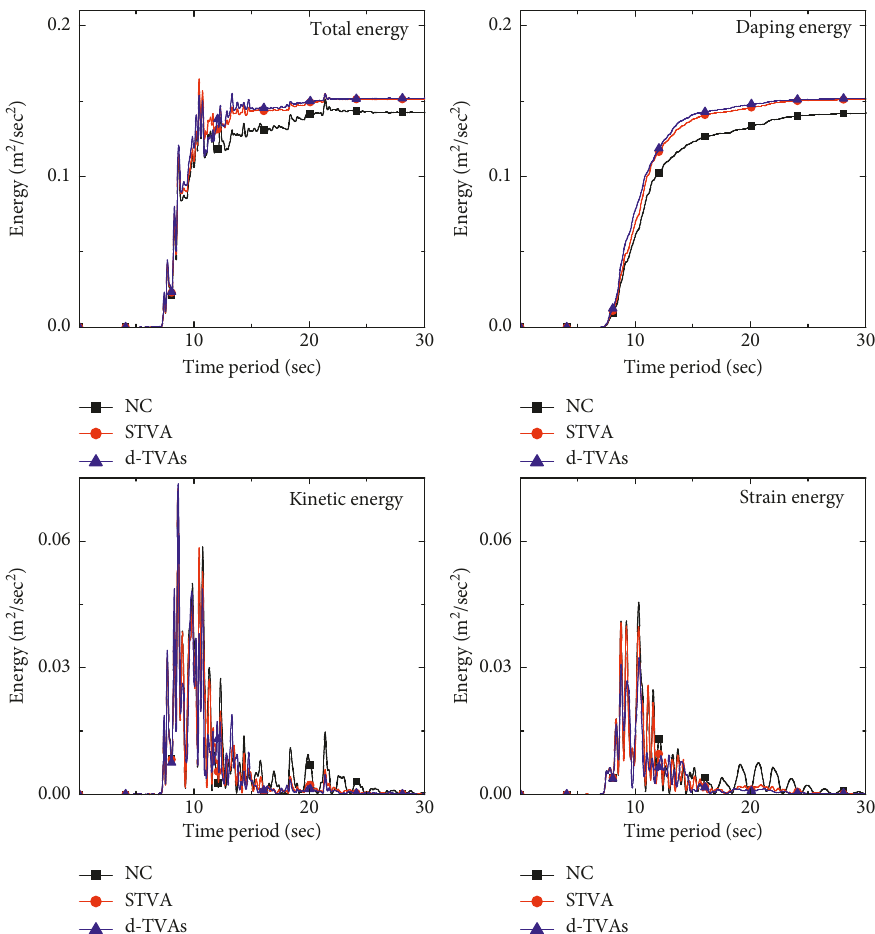
Figure 6: Different energies for the NC, STVA, and d-TVAs subject to Kobe, 1995 ground